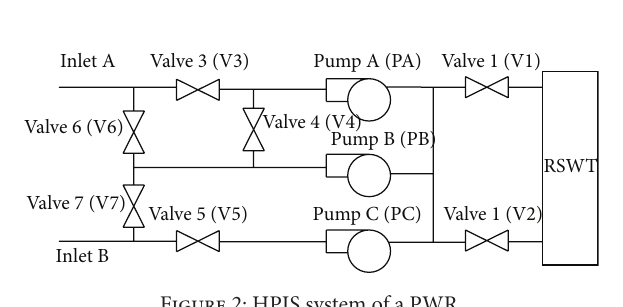
Figure 2: HPIS system of a PWR.